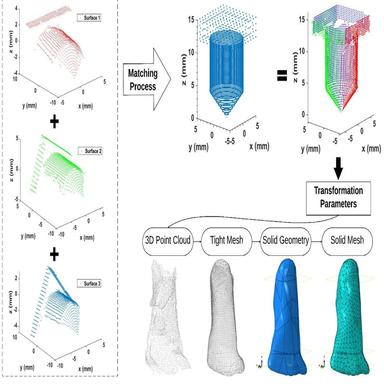
Schematics showing the process of mapping the three surfaces of the reference object (red, green and blue) on the virtual surface in order to obtain transformation parameters for the 3D digital image correlation test setup. Subsequently, the parameters were applied on to the 3D surfaces of the ligaments to construct 3D point clouds, which were then converted to tight mesh, solid geometry and finally continuous solid finite element models. (For interpretation of the references to color in this figure legend,